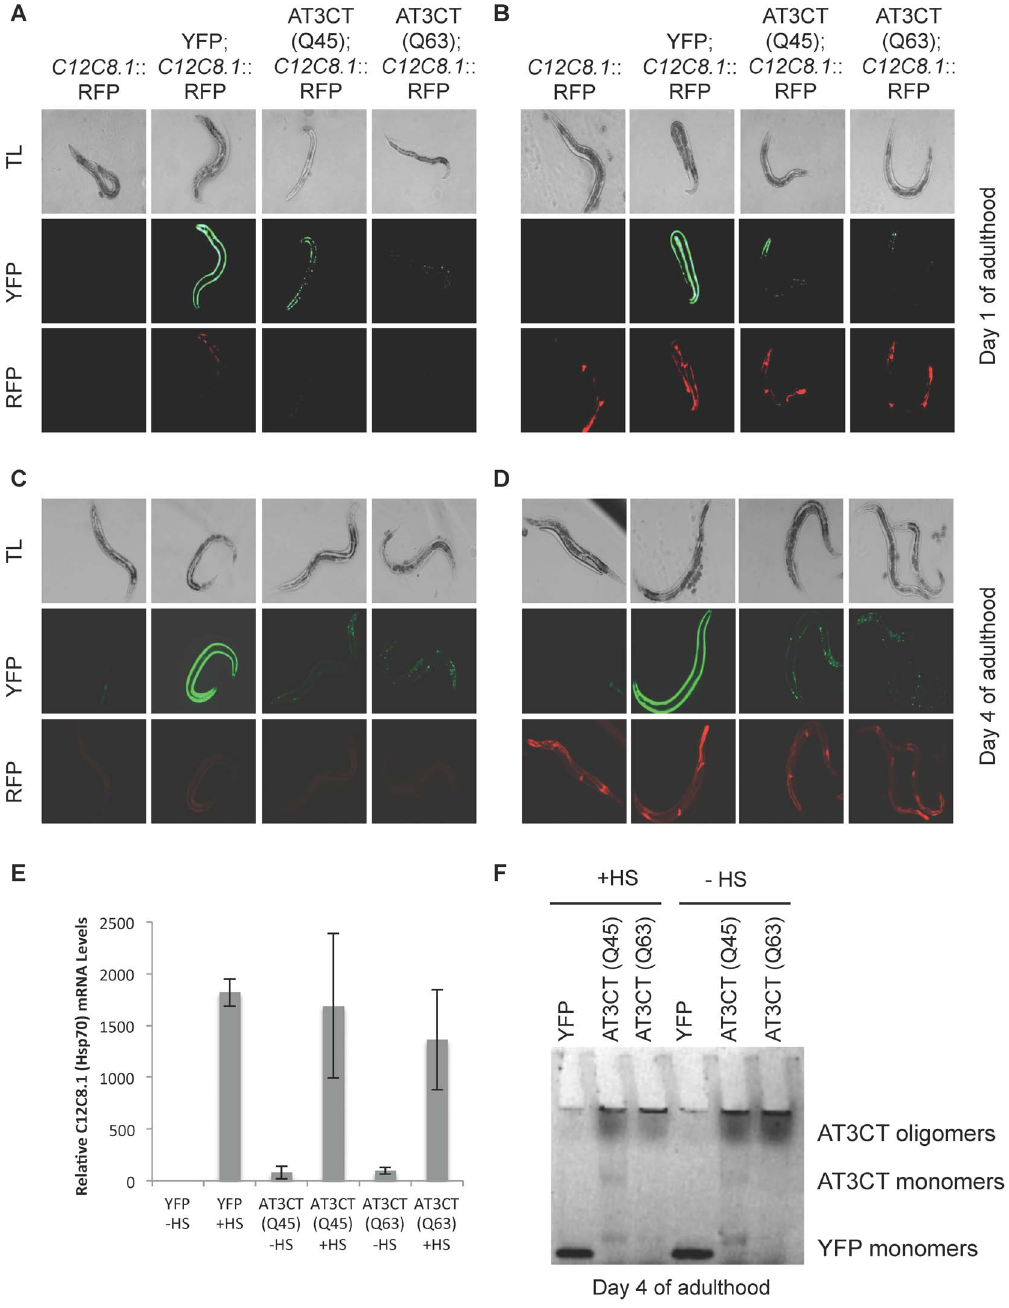
Figure 5. Effect of Heat Shock on C.elegans expressing AT3CT in body wall muscle cells. Animals expressing a reporter for the heat shock response